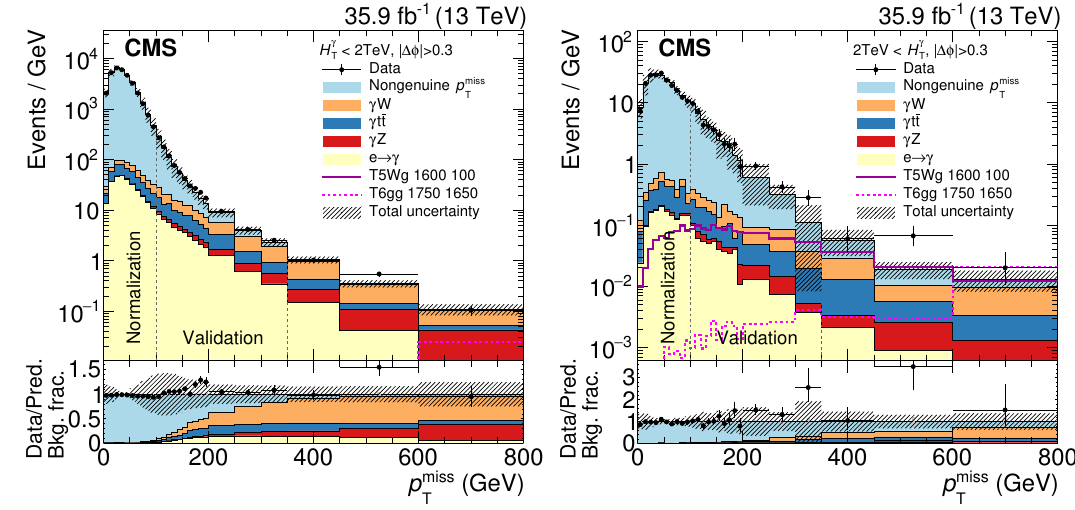
Figure 5 . Observed data compared to the background prediction. The expectation for the T5Wg signal scenario with a gluino mass of 1600 GeV and a gaugino mass of 100 GeV and the T6gg signal scenario with a squark mass of 1750 GeV and a neutralino mass of 1650 GeV are shown. The low- (high-) H (cid:13) selection is shown on the left (right). Below the p miss distributions, the data divided by T T the background prediction are shown as black dots, and the relative background components are shown as coloured areas. The last three bins in each plot correspond to the search regions. The rightmost bin includes all events with p miss > 600 GeV. T